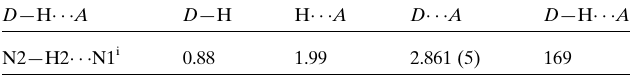
Table 1 Hydrogen-bond geometry (A˚ , (cid:3) ) for 1 .